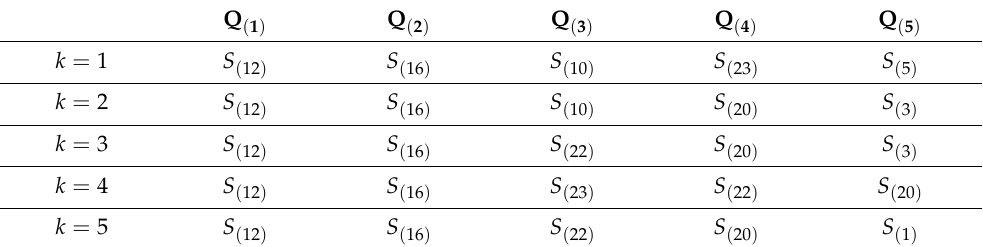
Table 5. The scenic spot tour sequence vector Q under the cluster quantity conditions.